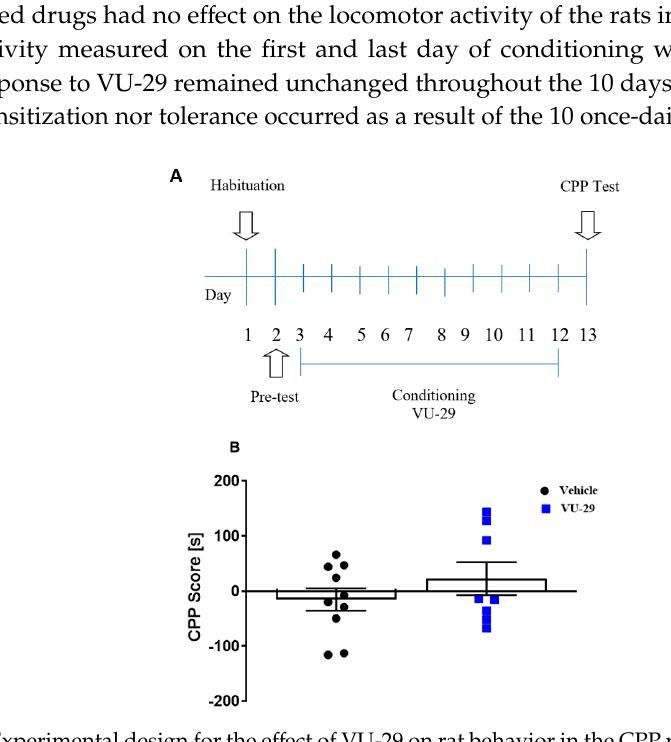
Figure 4. Experimental design for the effect of VU-29 on rat behavior in the CPP procedure ( A ). Data are shown as post-conditioning minus pre-conditioning time (s) spent in the drug-associated compartment in the CPP Test ( B ). Dots represent individual measurements, the central horizontal mark is the mean, and error bars represent SEM.